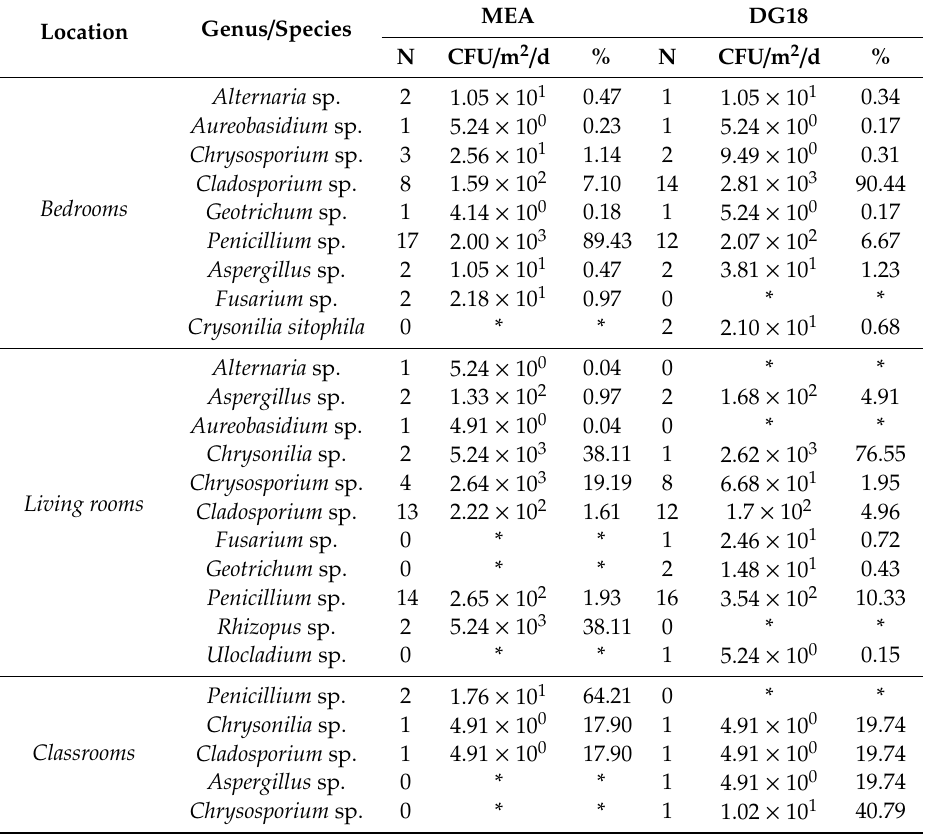
Table 4. Fungal species found in each studied